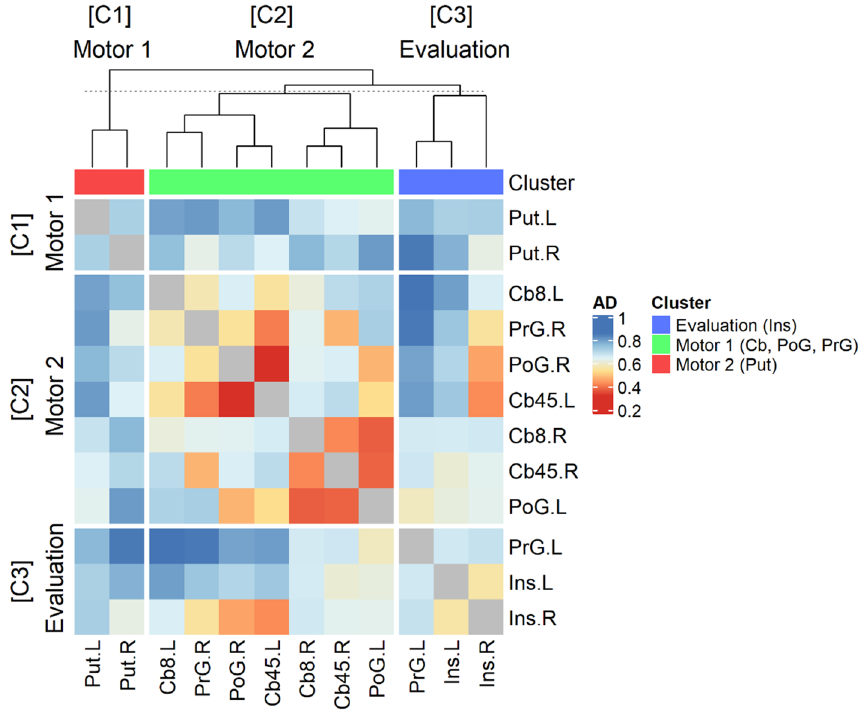
Figure 6. A heatmap with the result of hierarchical clustering. The order of both row and column was determined by hierarchical clustering algorithm as follows: (1) left putamen (Put.L), (2) right putamen (Put.R), (3) left cerebellum 8 (Cb8.L), (4) left cerebellum 4/5 (Cb45.L), (5) right cerebellum 8 (Cb8.R), (6) right cerebellum 4/5 (Cb45.R), (7) right precentral gyrus (PrG.R), (8) left postcentral gyrus (PoG.L), (9) right postcentral gyrus (PoG.R), (10) left precentral gyrus (PrG.L), (11) left insula cortex (Ins.L), and (12) right insula cortex (Ins.R). Each cell indicates Pearson correlation distance between brain